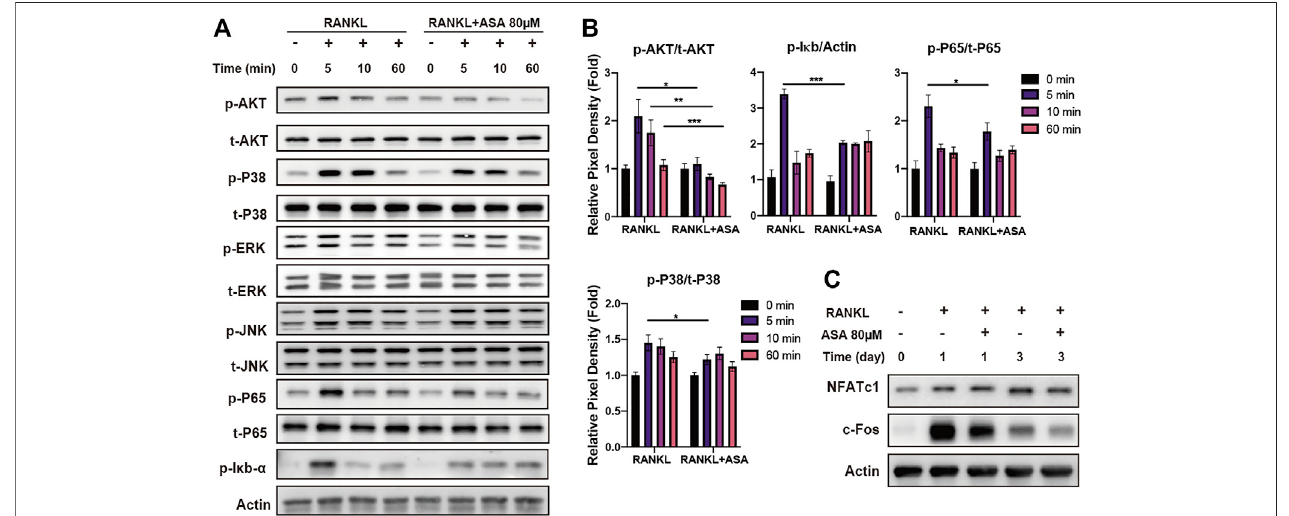
FIGURE 3 | ASA attenuated RANKL-induced AKT, p38 phosphorylation and NF- κ B signaling through NFATc1/c-fos. (A) BMMs were treated with/without 80 μ M ASA (0.1% DMSO as a control) for 2 h, followed by 50 ng/ml RANKL for the indicated miniates. Cell lysates were then subjected to Western blotting analysis for p-AKT, t-ATK, p-p38, t-p38, p-I κ B- α , p-p65, t-p65, p-ERK, t-ERK, p-JNK1/2, t-JNK1/2. (B) The quanti fi ed p-AKT/p-I κ B- α /p-p65/p-p38 protein expression was normalized to total AKT/actin/p65/p38,relatively. * p < 0.05, ** p < 0.01, *** p < 0.001 vs control (C) BMMs weretreatedby 50 ng/ml RANKL inthe presence ofASA (0.1% DMSO as a control) for 1, 3, 5 days. Cell lysates were then subjected to Western blotting analysis for NFATC1, c-fos and β -actin. β -actin served as the internal